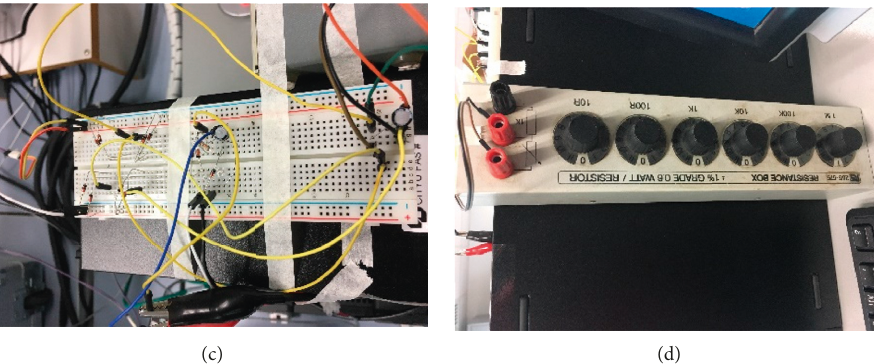
Figure 6: Experiment and the configuration setup: (a) the designed structure; (b) the baseline structure; (c) the electric circuit; (d) the external resistor.